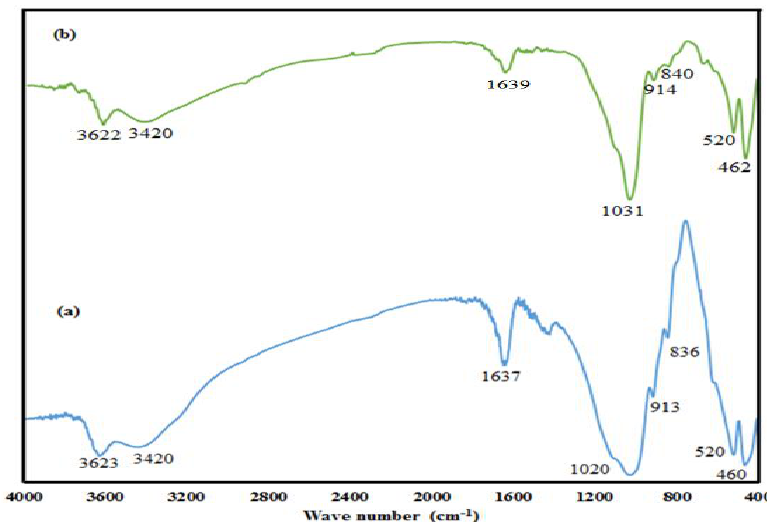
Fig. 1. FT-IR spectra of raw nanobentonite (a) and activated nanobentonite